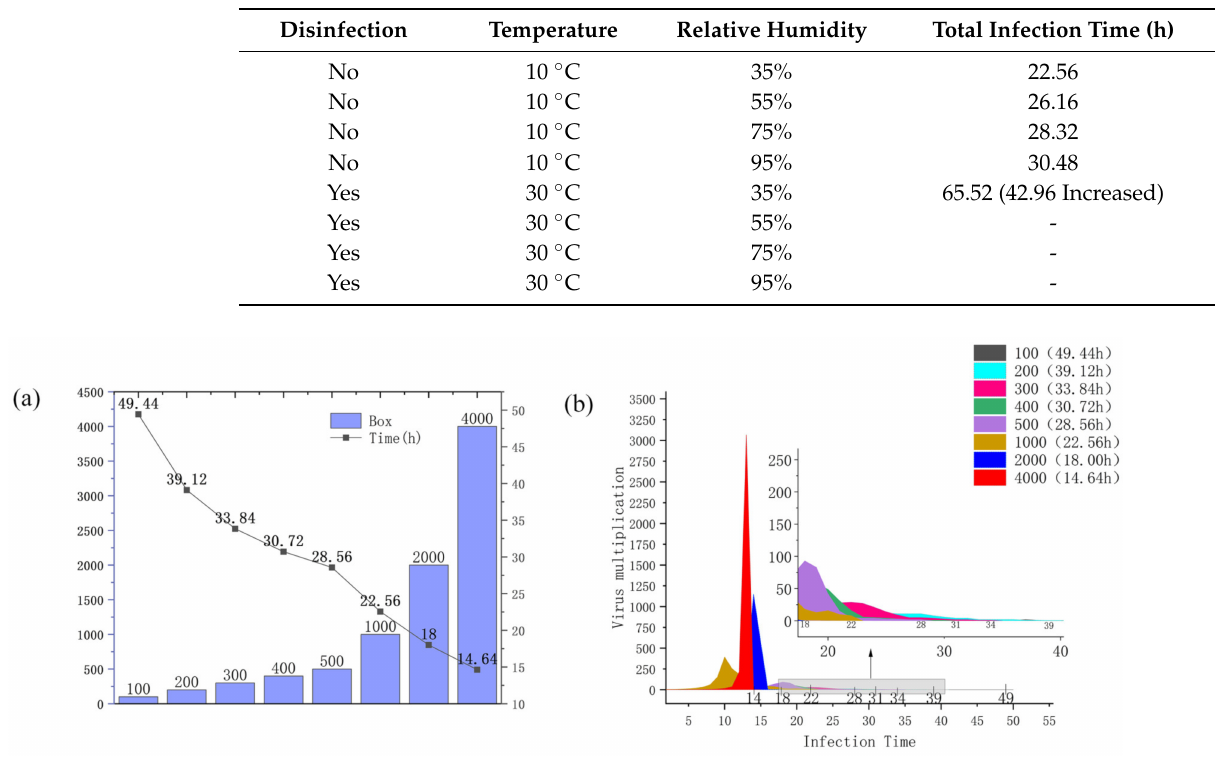
Figure 4. ( a ) Relationship between the number of boxes and the time of infection, ( b ) Change of virus infection rate at different number of